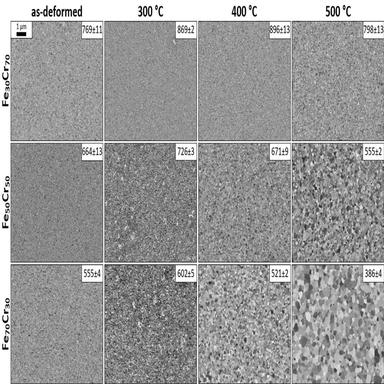
BSE images of the microstructure of HPT-deformed FeCr alloys. The Fe content increases from the top to the bottom row. The first column shows the microstructure of as-deformed samples. The next columns depict microstructural changes with increasing annealing temperatures (300 ◦C, 400 ◦C and 500 ◦C, respectively). Averaged Vickers-hardness values are depicted in the corresponding images as insets. The magnification is the same in all images.